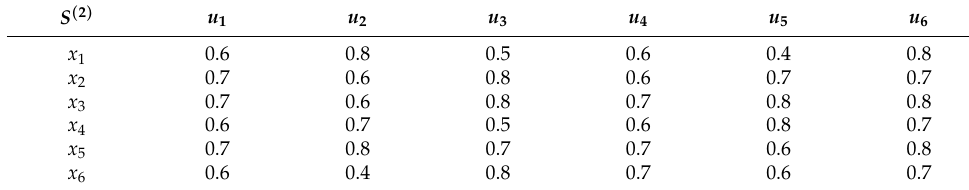
Table 4. Appraisal of expert e 2 .